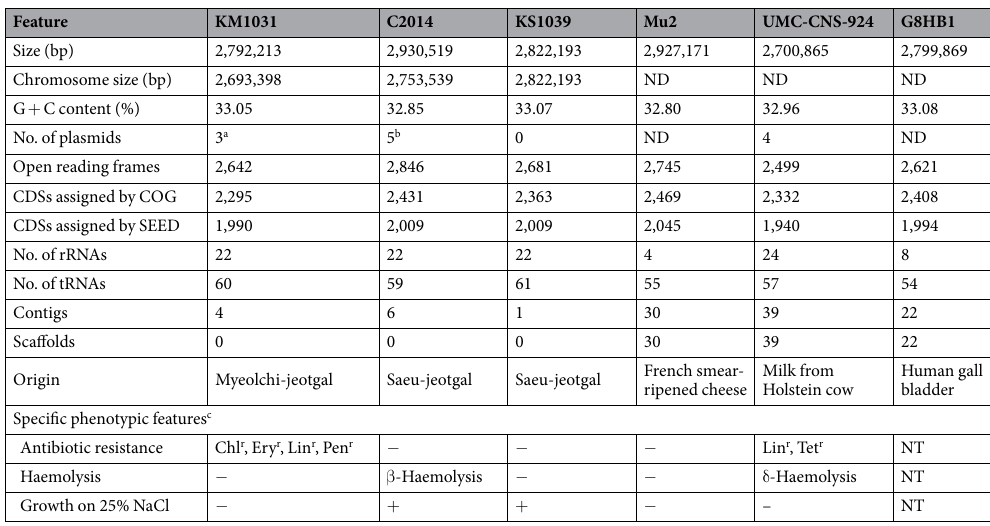
Table 1. General genomic and specific phenotypic features of six Staphylococcus equorum strains. a Plasmids in the strain KM1031: pKM1031-1, 45.9 kb; pKM1031-2, 50.2 kb; and pSELNU3, 2.6 kb. b Plasmids in the